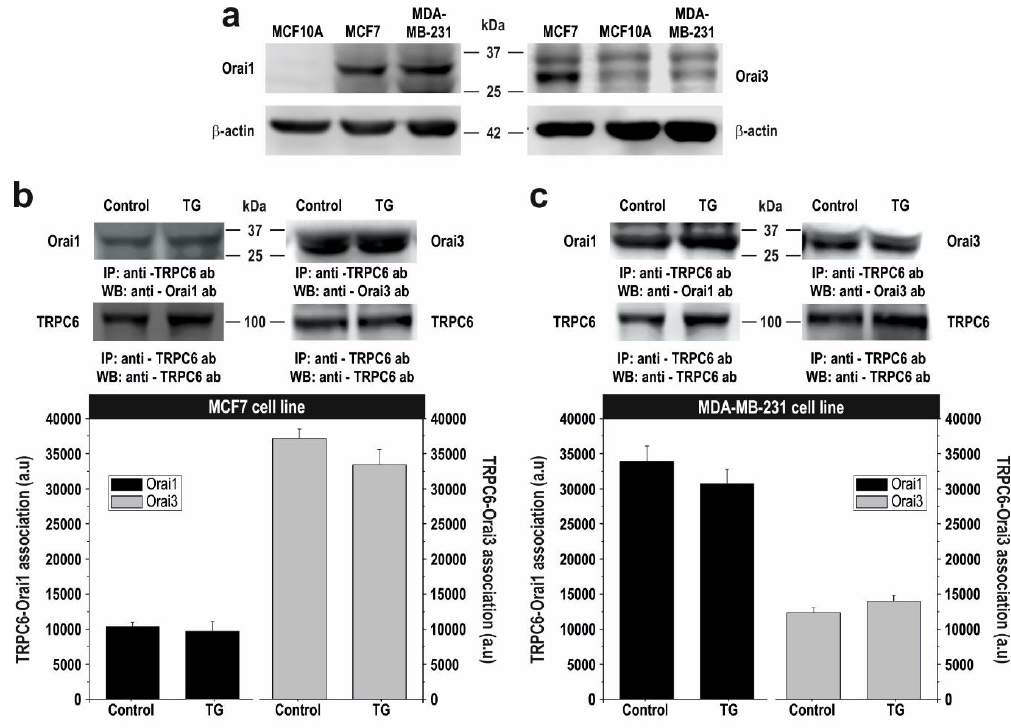
Figure 6 . Cont. Figure 6.